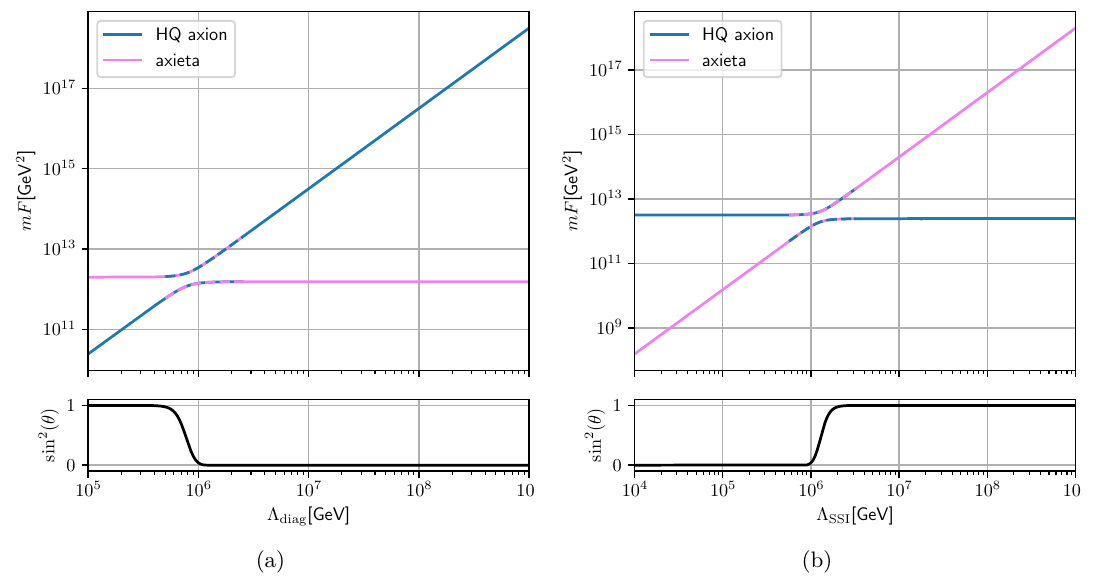
Figure 4 . The axion and axieta masses in eqs. (4.16) and (4.17) as a function of (a) Λ diag with Λ SSI = 10 6 GeV and (b) Λ SSI with Λ diag = 10 6 GeV. The avoided crossing behavior is highlighted at the non-degenerate symmetry point with a dashed line. In the lower panels, we show the mixing angle for the axion component of the heavier mass